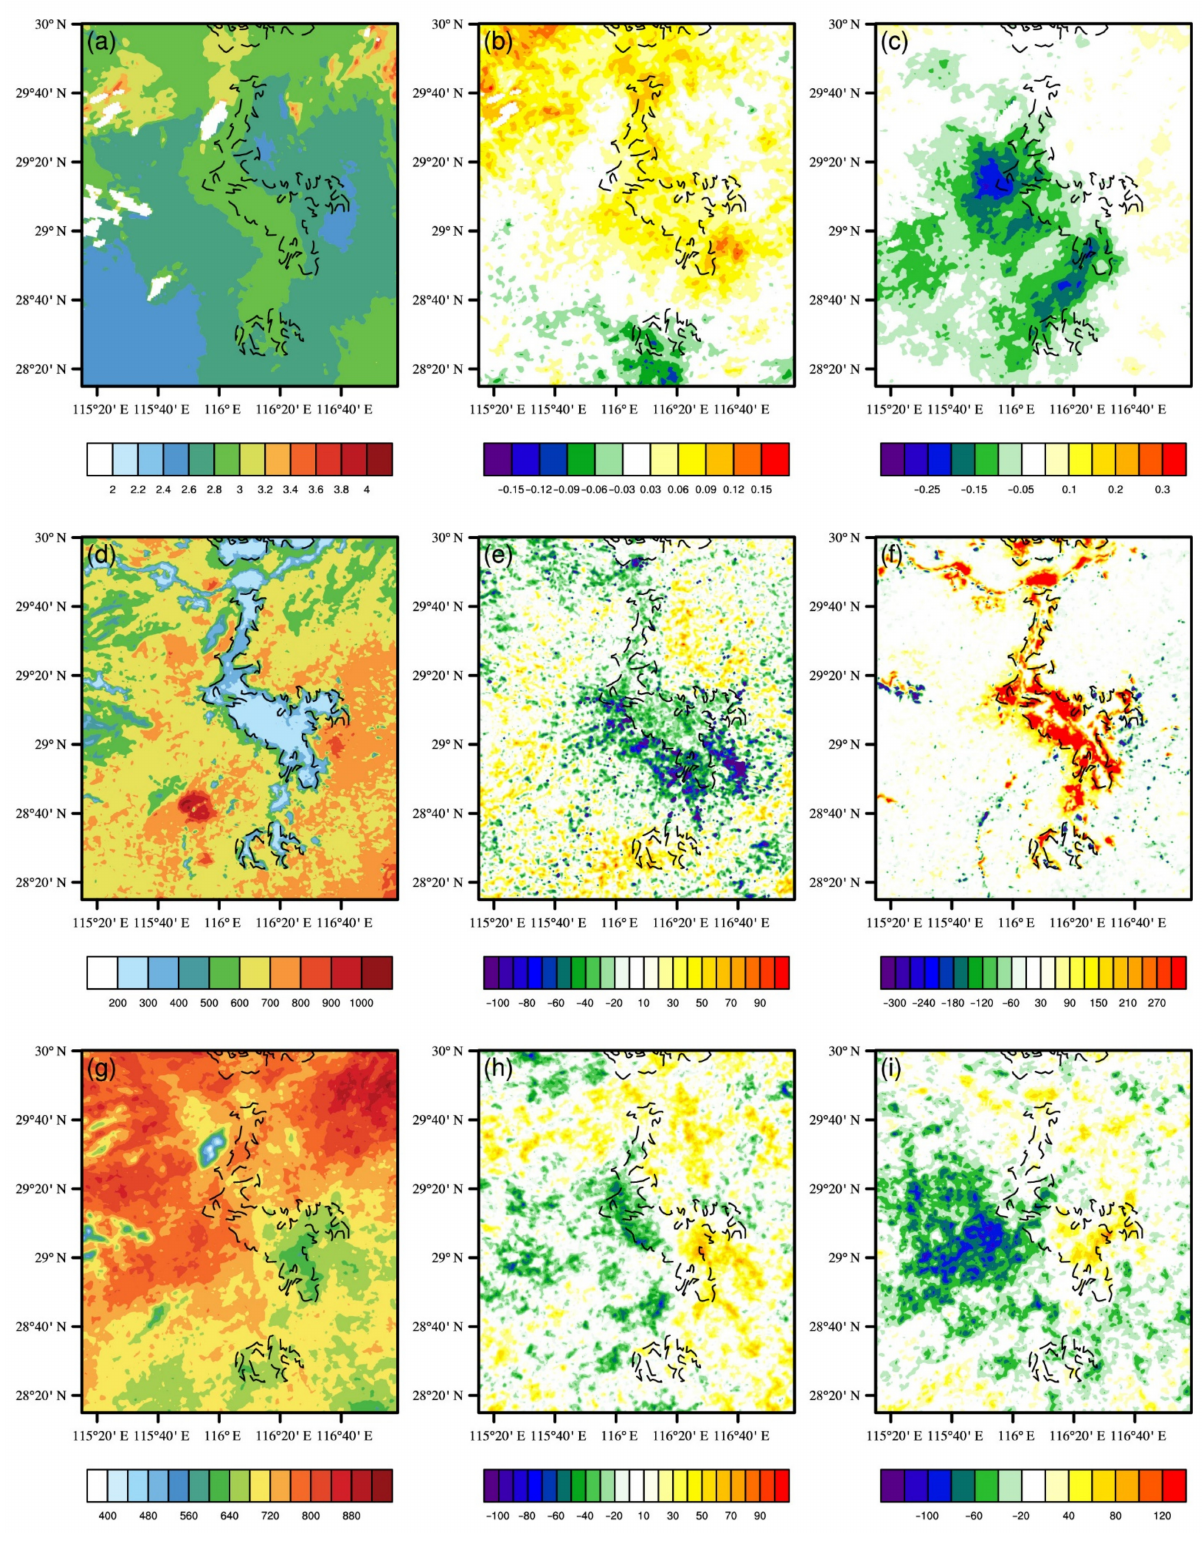
Figure 6. The distribution of the mean ( a – c ) potential temperature difference between 850 hPa and 1000 hPa (K), ( d – f ) the planetary boundary layer height (PBL) (m, and ( g – i ) CAPE (J kg − 1 ) from 13 to 31 July. The control experiment (CTL) is shown in ( a , d , g ). The difference between the CTL and EXPT1 (EXPT1–CTL) is shown in ( b , e , h ). The difference between the CTL and EXPT2 (EXPT2–CTL) is shown in ( c , f , i ). The black dashed line maps the Poyang Lake area in the